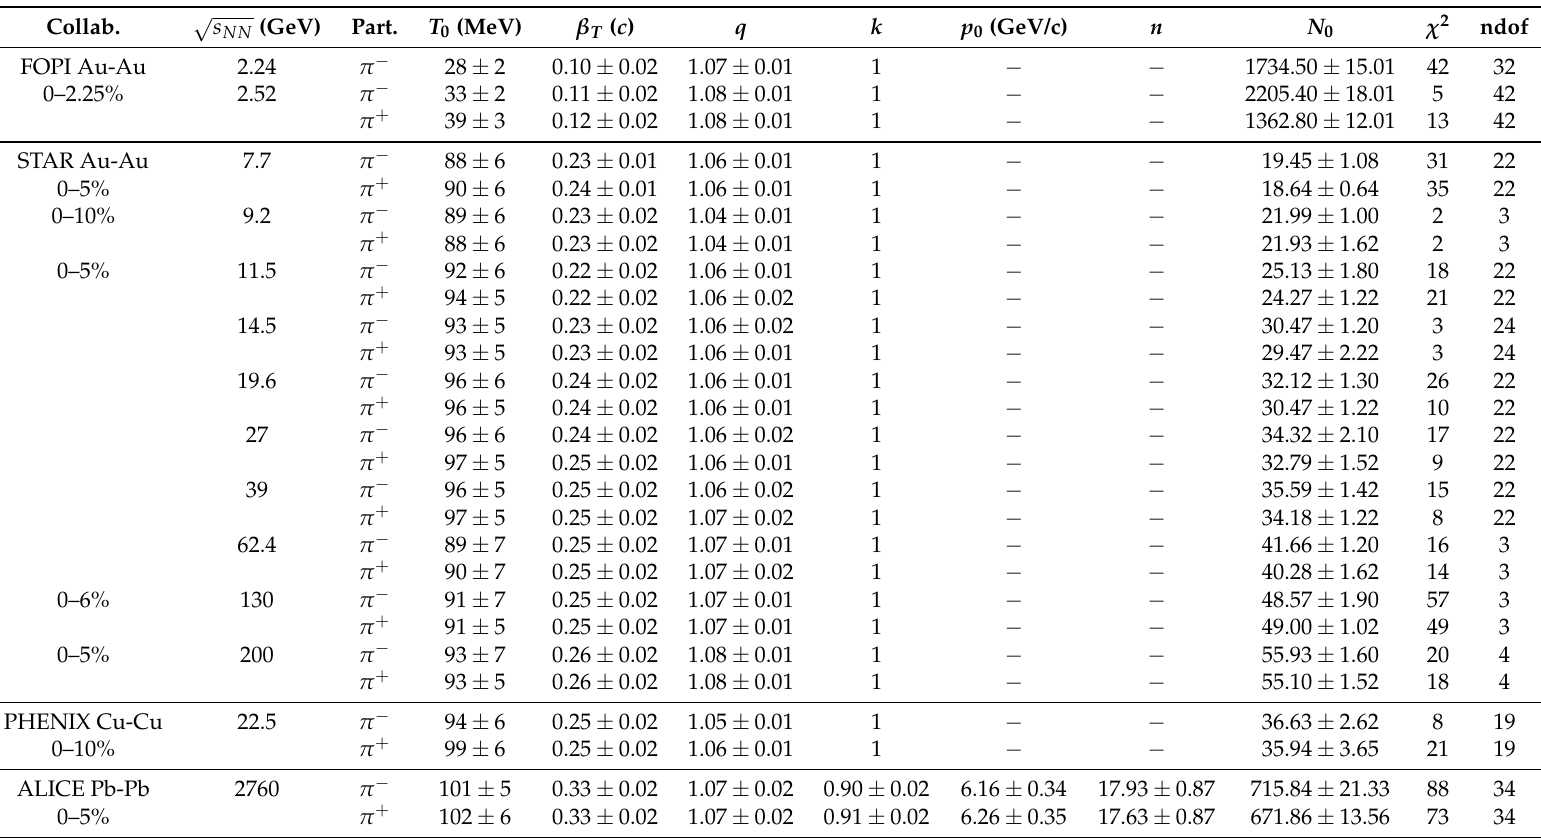
Table A2. Values of T 0 , β T , q , k , p 0 , n , N 0 , χ 2 , and ndof corresponding to the dashed (dot-dashed) curves for π − ( π + ) spectra in Figure